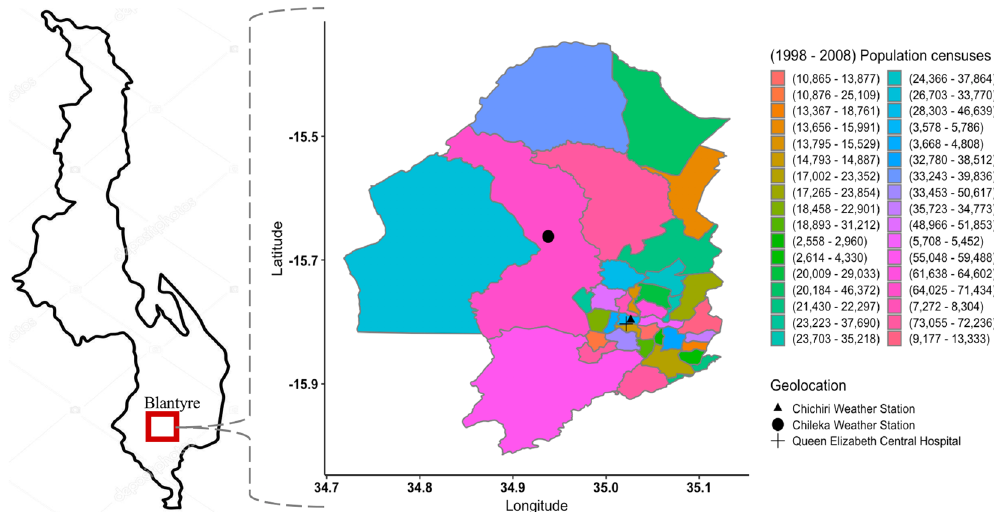
Figure 1. The map of Blantyre, Malawi. Shows locations by longitude and latitude of the weather stations (Chichiri and Chileka) which captured daily rainfall and temperature, Queen Elizabeth Central Hospital where invasive nontyphoid and typhoid cases were diagnosed, and the total population enumerated during 1998 and 2008 national censuses in